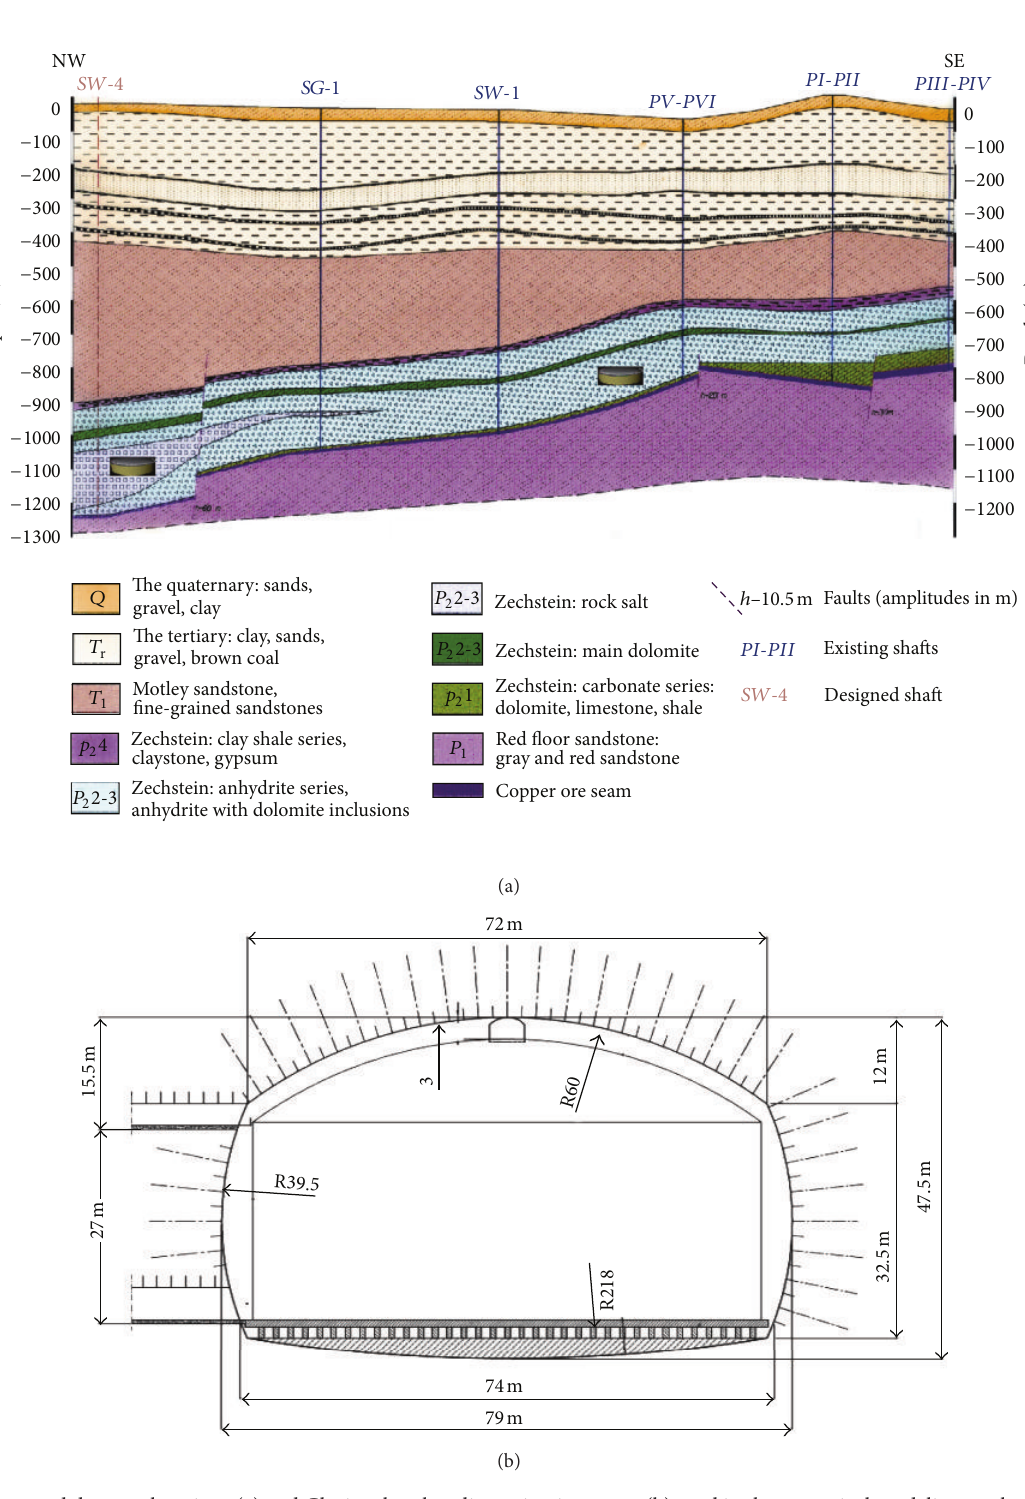
Figure 9: Proposed detector locations (a) and Glacier chamber dimension in meters (b) used in the numerical modeling on the basis of